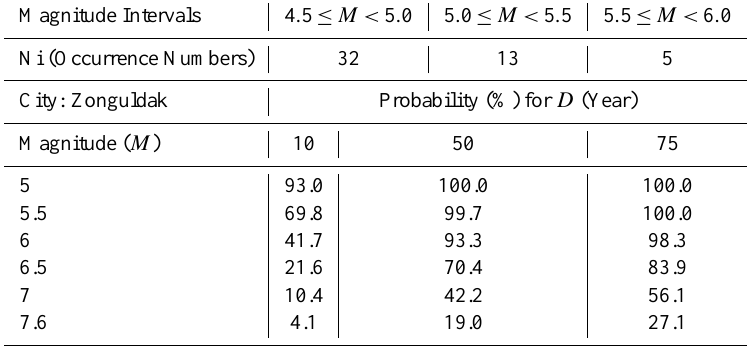
Table 3w. Earthquake occurrence probability (%) for D (Year) for Zonguldak